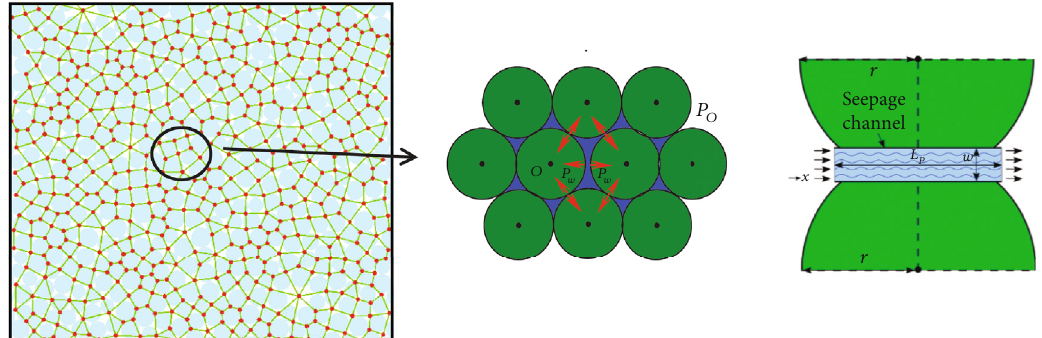
Figure 2: Pipeline and domain in PFC 2D [30].